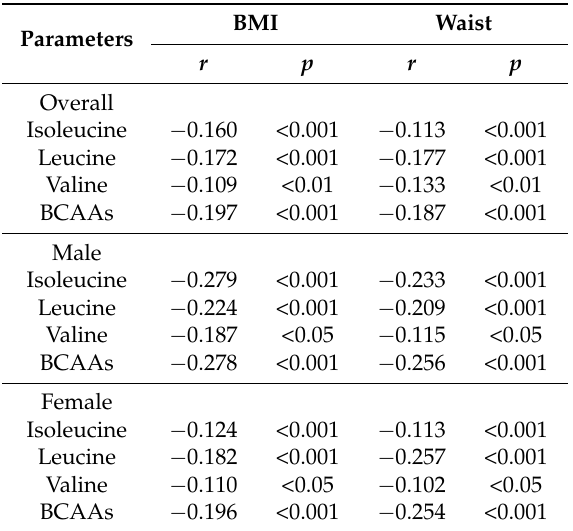
Table 2. Partial correlation analysis of ratio of BCAAs, isoleucine, leucine, and valine versus BMI and waist.